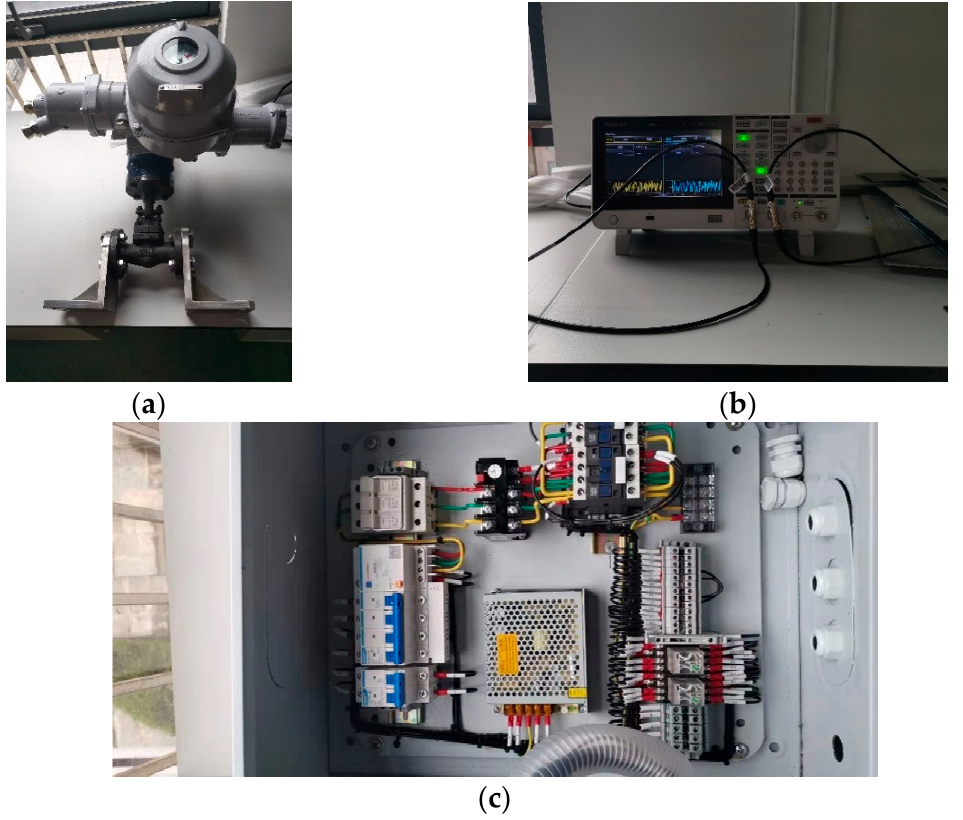
Figure 6. Nuclear power valve testing device: ( a ) nuclear power valve, ( b ) signal generator, and ( c ) control circuit of the nuclear power valve.